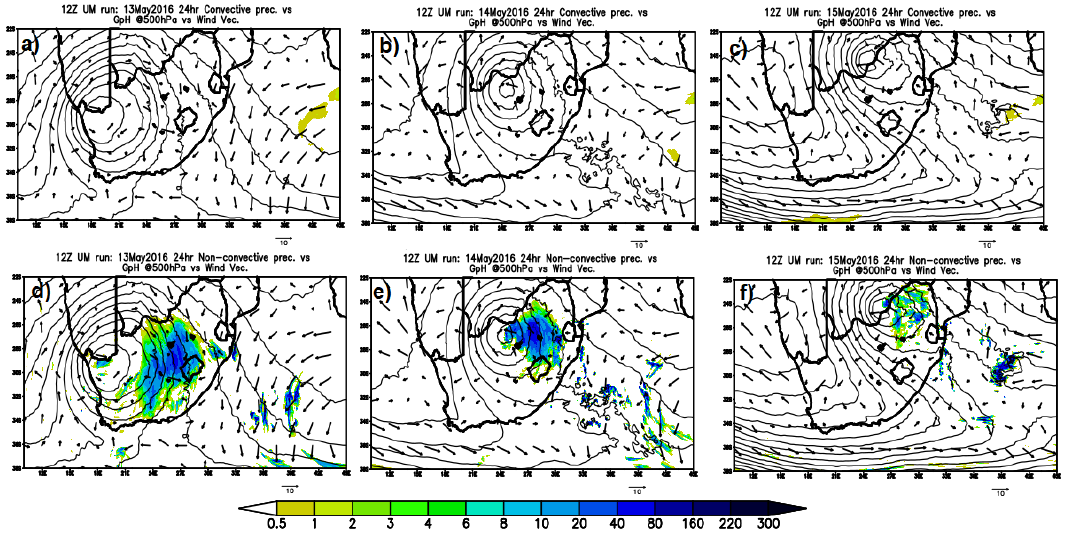
Figure 3. Geopotential heights at 500 hPa (thin contours) together with convection precipitation ( a,b,c ) at 12Z UM 24 h on the 13th, 14th and 15th May 2016. Bottom panels ( d,e,f ) are for the same time as in (a,b,c )but for non-convective precipitation. The vectors represent the wind vectors at 10 m above the